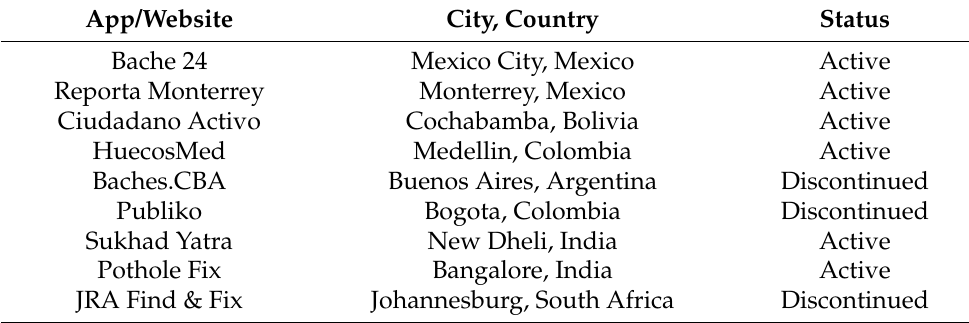
Table 1. Public reporting platforms in developing